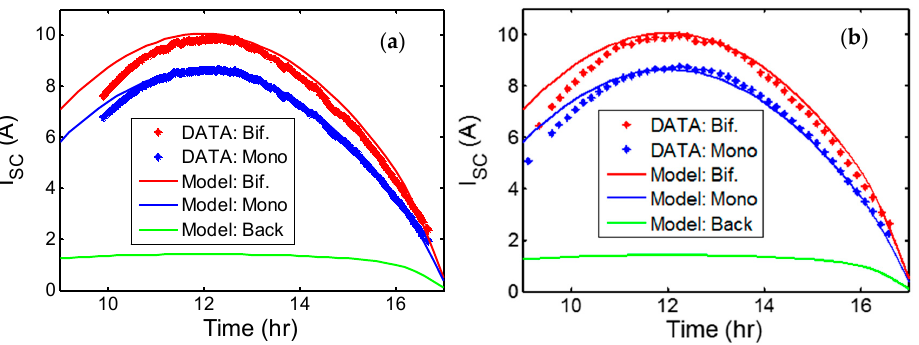
Figure 5. Data of a single day of module I SC compared with the values predicted by the model ( a ) and average values compared with the model ( b ). The model allows also to separately calculate the current generated by the back surface of the module.